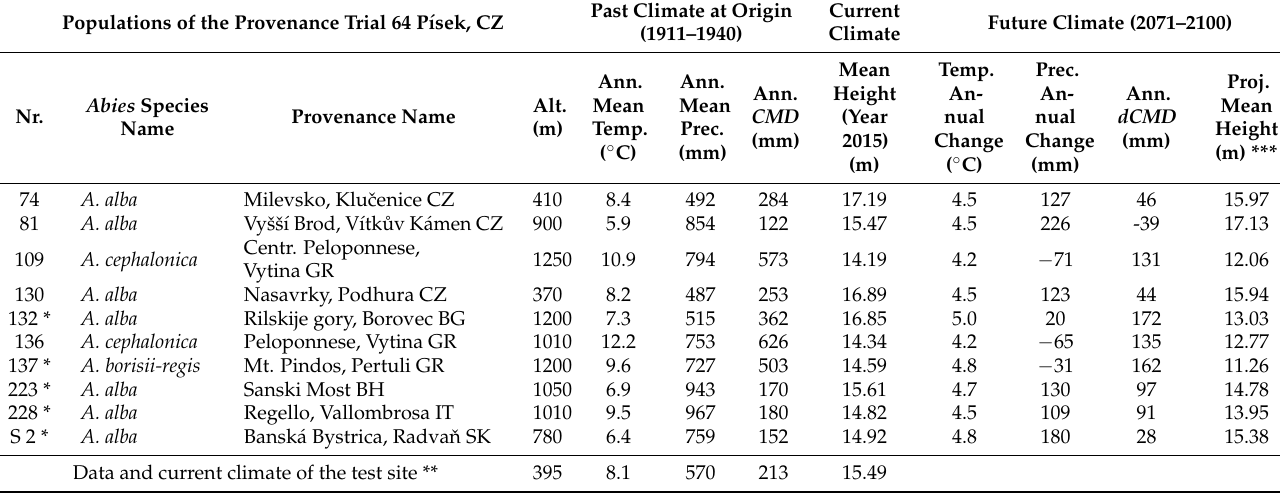
Table A4. Climate parameters of silver and Balkan firs in the past, current heights (in P í sek) and projected climatic changes (related to the past) and projected (Proj.) heights at their original location of provenance (see also Figure 5). Populations of the Provenance Trial 64 P í sek, CZ